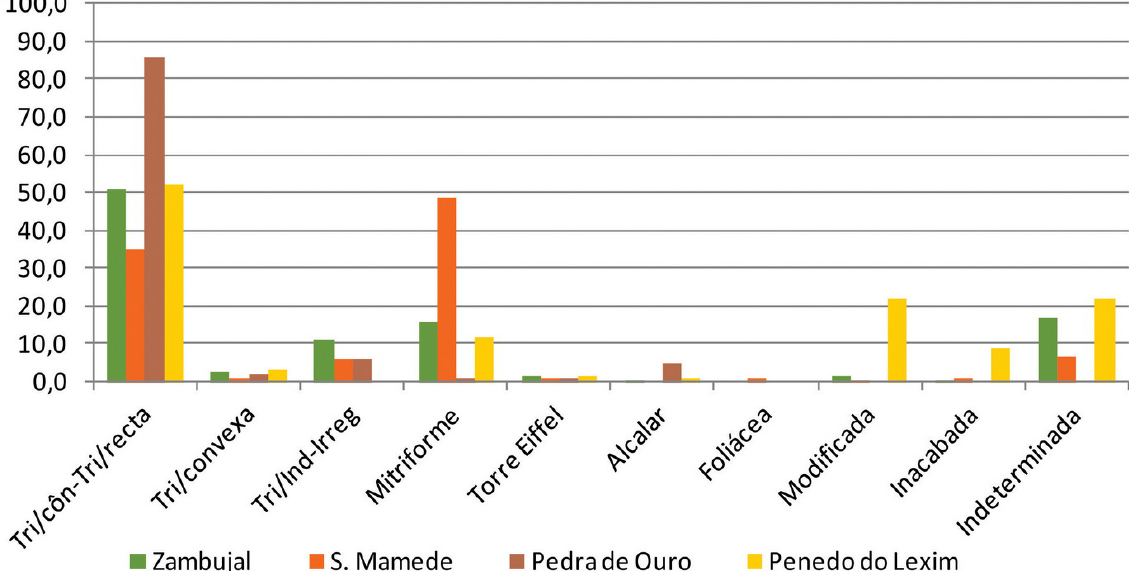
Figura 4. Morfologia dos bordos das pontas de seta do Zambujal, S. Mamede, Pedra de Ouro e Penedo do Lexim com os valores “Tri/côncava” e “Tri/recta” determinados em conjunto de forma homogénea para todos os sítios (em %). Figure 4. Zambujal, S. Mamede, Pedra de Ouro & Penedo do Lexim arrow points morphology of the edges. With “Tri/côncava”and “Tri/recta” values determined in groups of homogene form to all the sites (in %). Foi possível identificar a morfologia em cerca de 85% dos casos. Olhando para